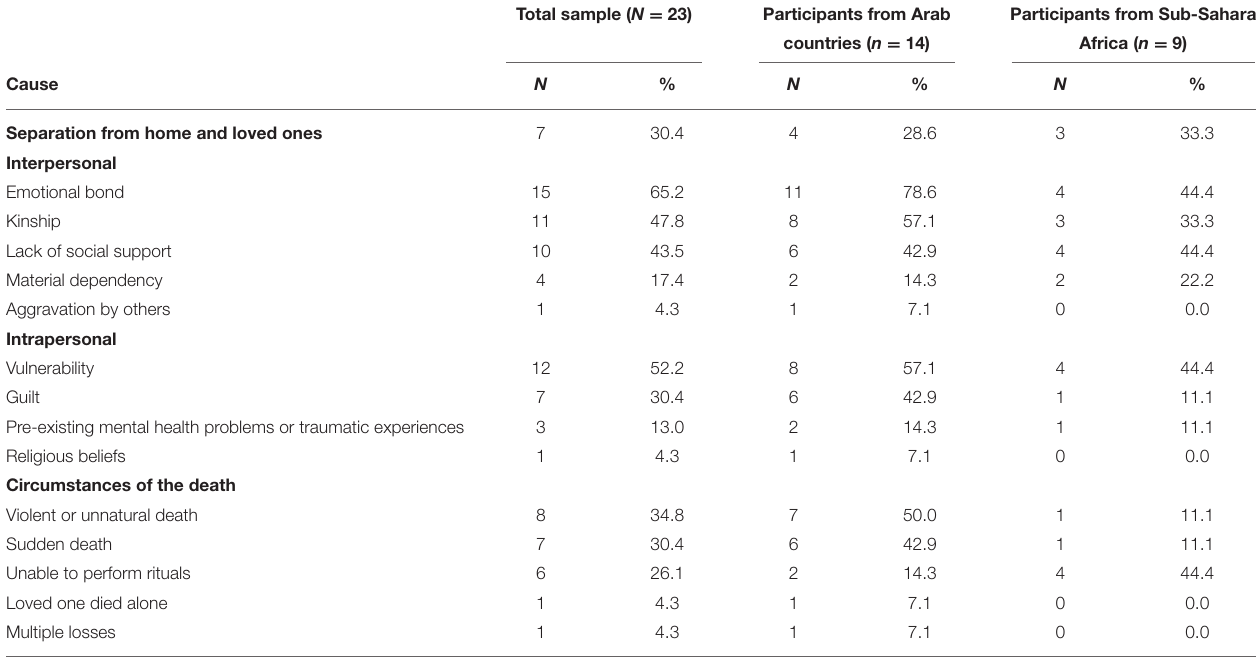
TABLE 2 | Causes of PGD